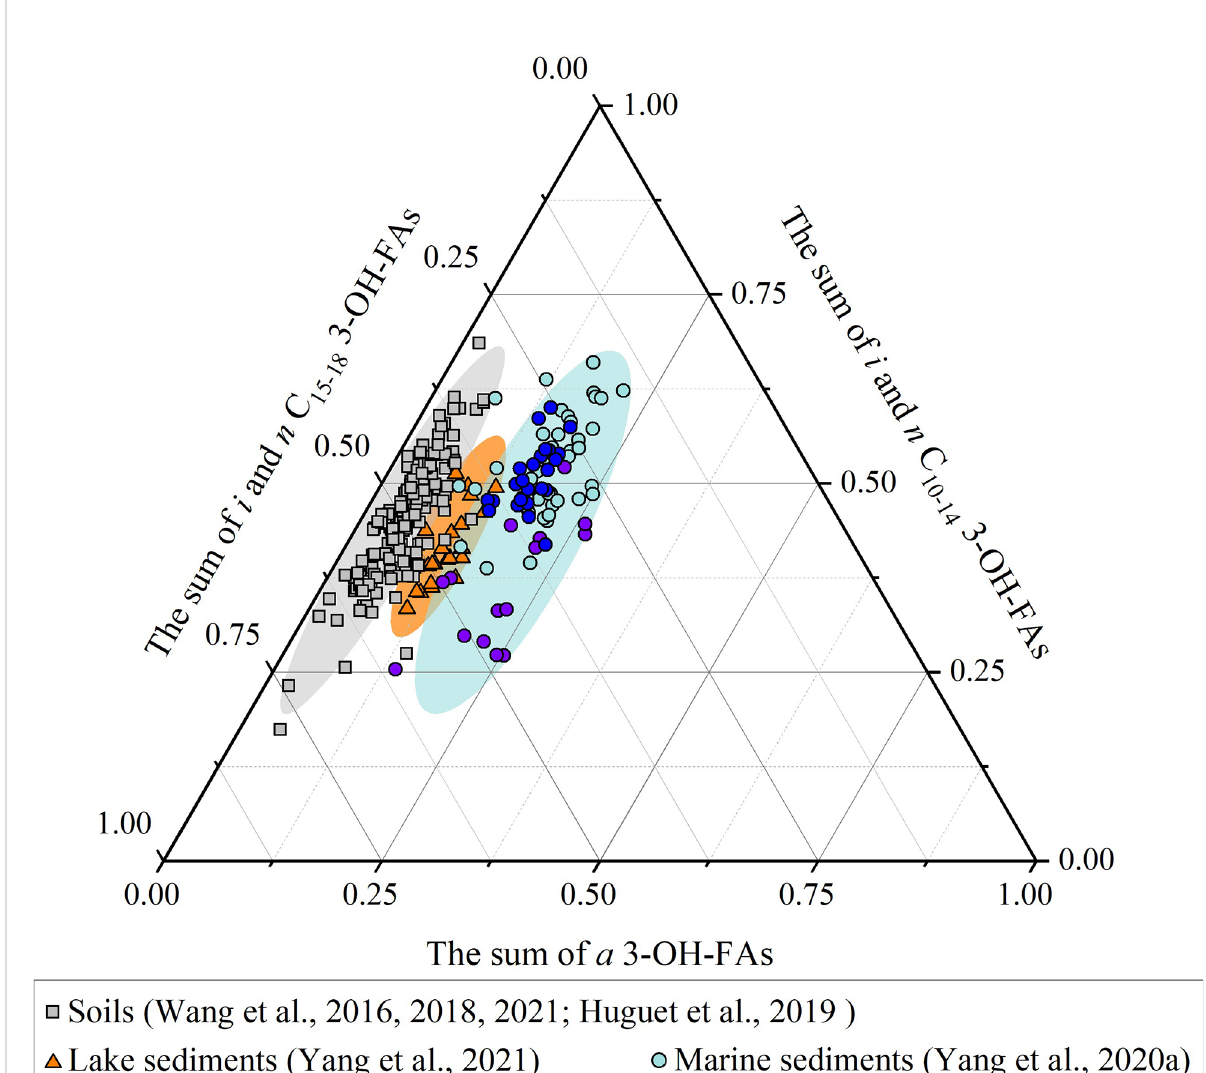
FIGURE 6 Ternary plot showing the relative abundance of 3-OH-FAs homologues in soils (Wang et al., 2016; Wang et al., 2018; Huguet et al., 2019, Wang et al., 2021a), lake surface sediments (Yang et al., 2021), marine surface sediments (Yang et al., 2020a and this study). The grey, orange, and blue ellipses show the main distribution area of soils, lake surface sediments and marine surface sediments distribution in the ternary plot,